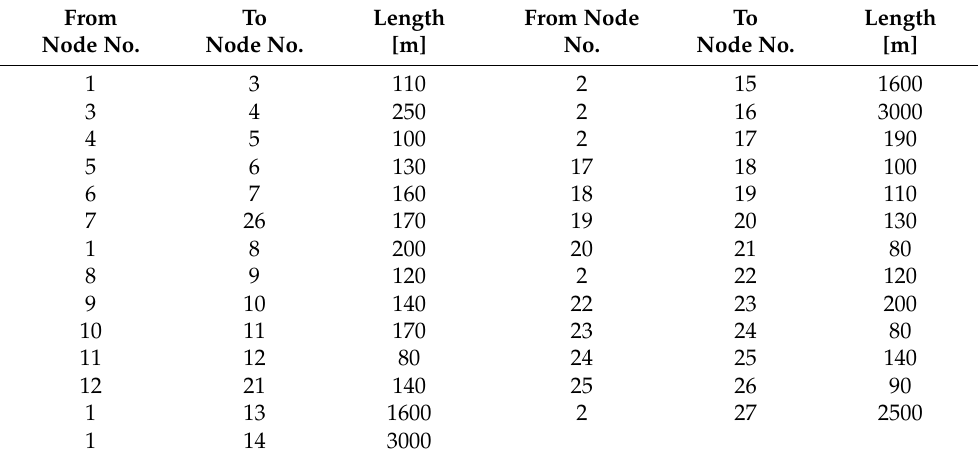
Table A6. Line parameters of the MV distribution network with LV microgrids. From To Node No. Node